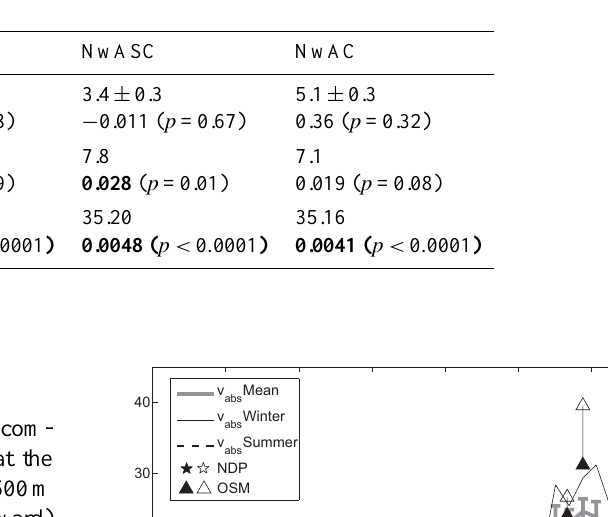
Table 2. Long-term means and trends of volume flux, temperature and salinity in the two branches NwAFC and NwASC, and total inflow, NwAC. Standard error estimates of volume fluxes are included. Trends and trend significances, where p is the probability level, are calculated from annual values, and trends with 99% or higher significance are bolded.